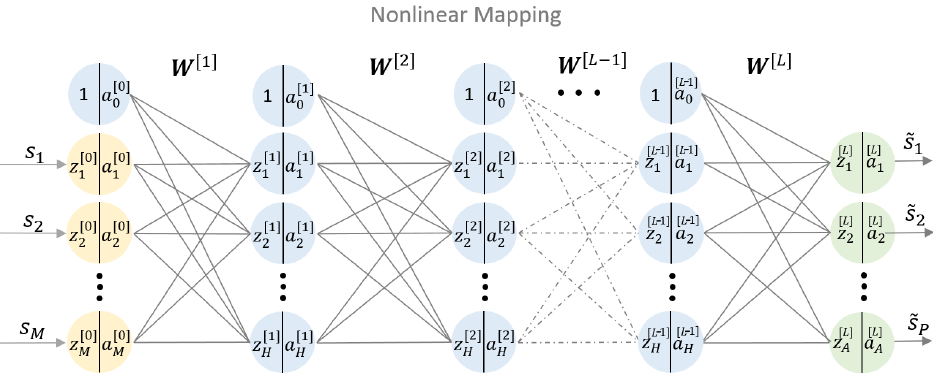
Figure 3. L -layers feed-forward deep neural networks (DNN) with M nodes in the input layer, H nodes in the hidden layers and A nodes in the output